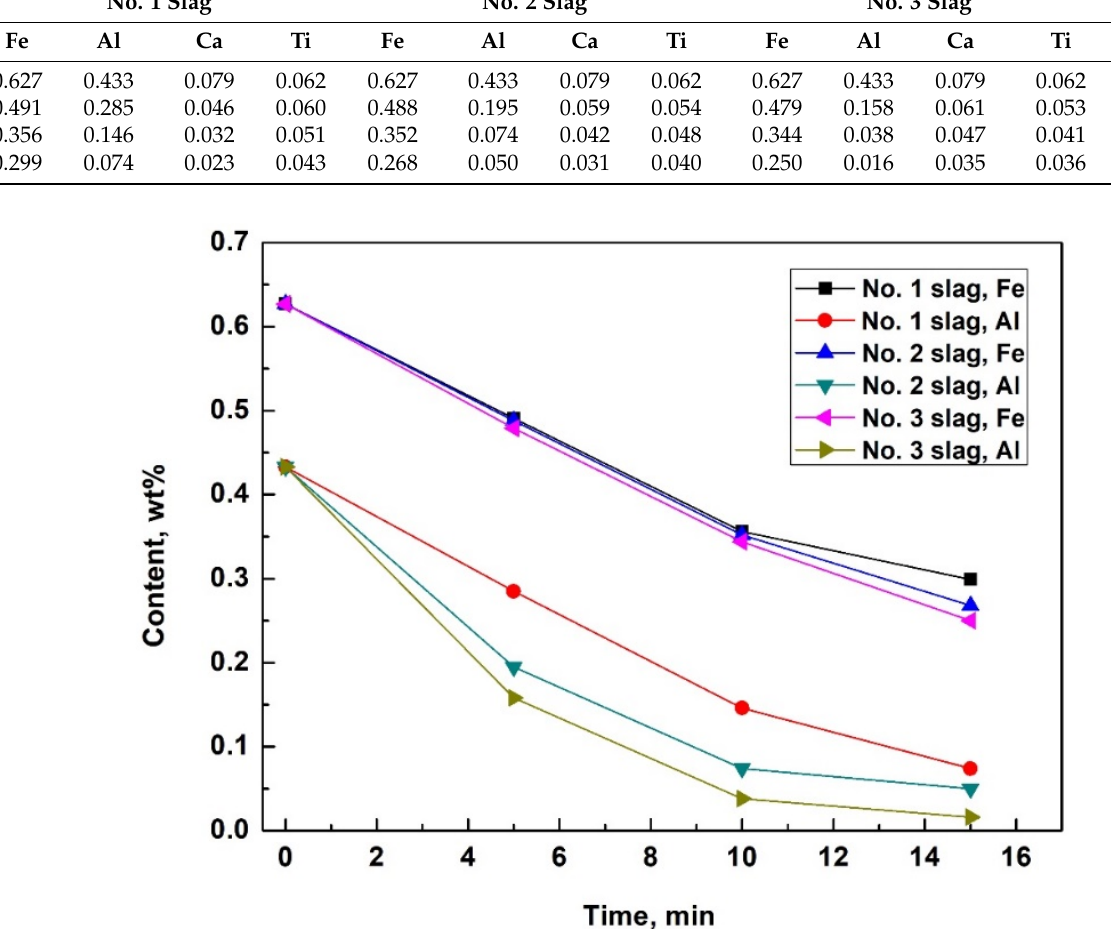
Figure 1. Fe and Al content of MGS during refinement using slags with three different binary basicities (0.4 for No. 1 slag, 0.5 for No. 2 slag, and 0.6 for No. 3 slag). The calculated yields of silicon after refining are 98.6%, 98.1%, and 98.0% for No. 1, No. 2, and No. 3 slag, respectively. Repetition of the experiments exhibited no obvious statistical differences on the impurity removal efficiencies and silicon